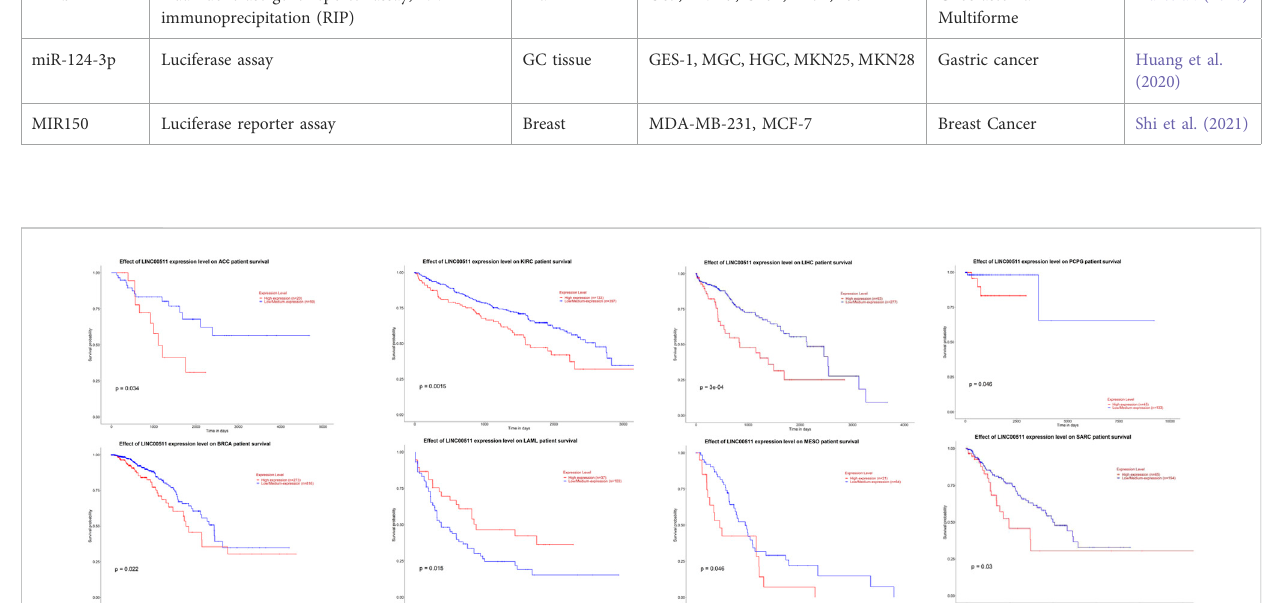
FIGURE 3 The impact of LINC00511 on survival of patients with different